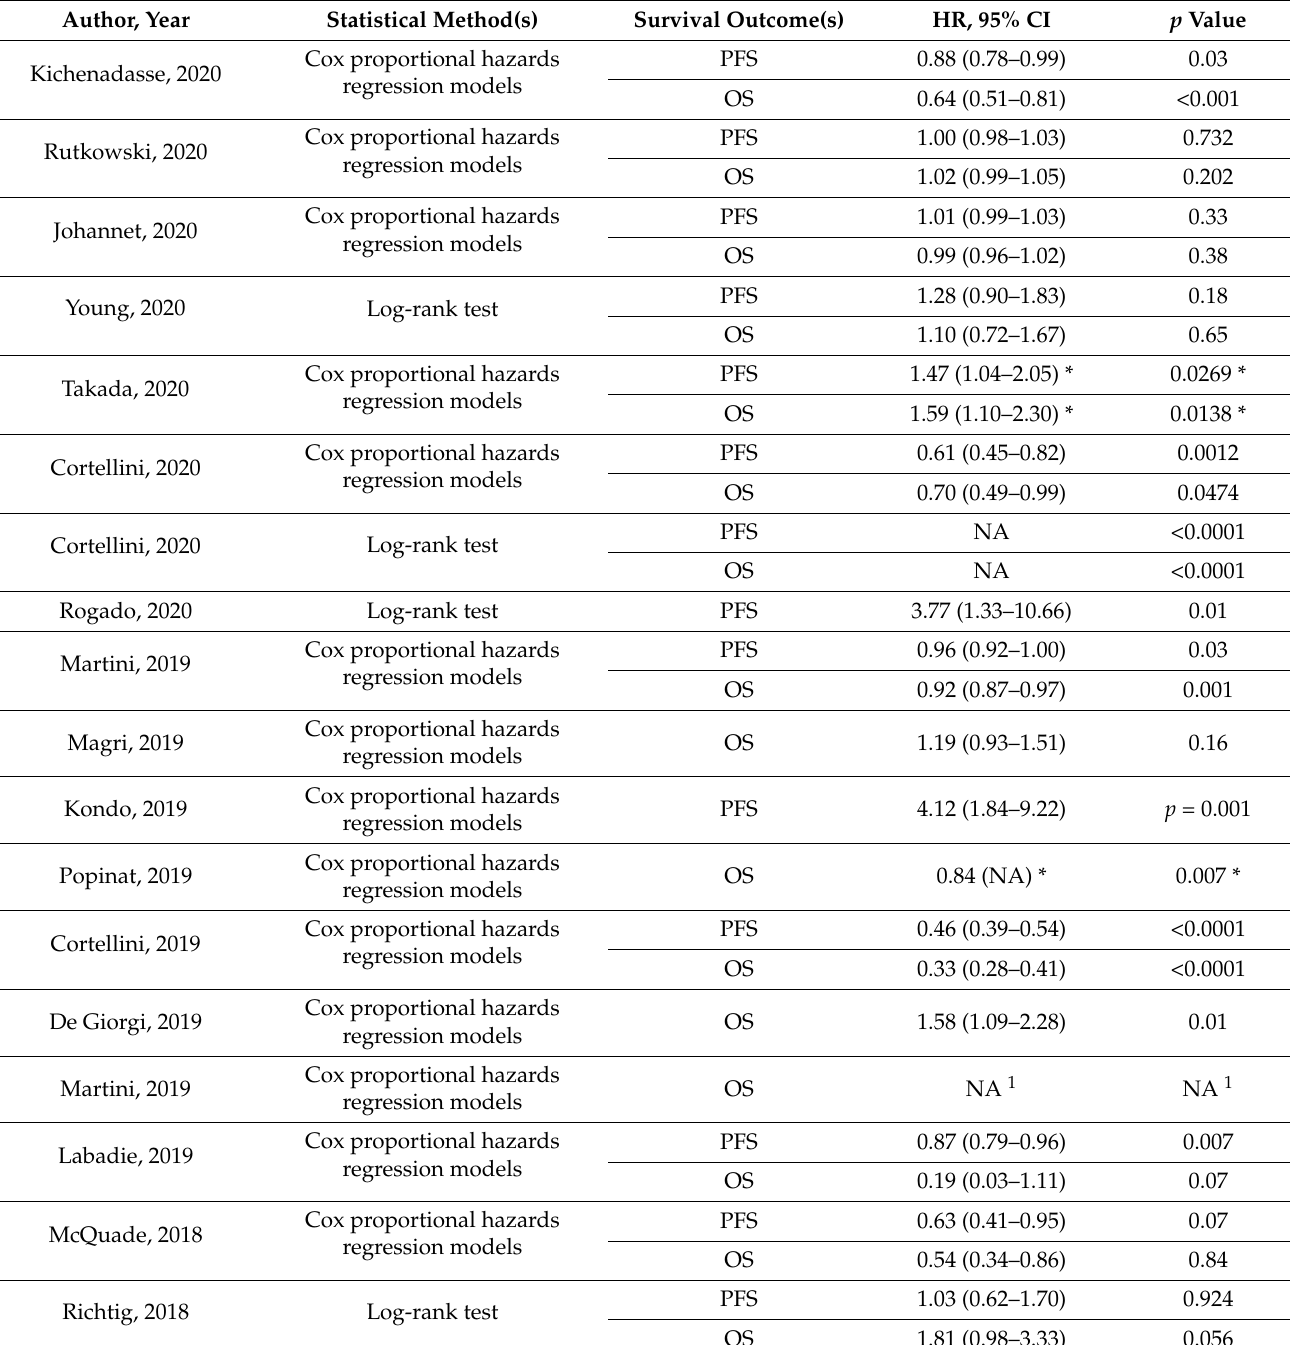
Table 3. Overview of statistical methods and results of the analyzed